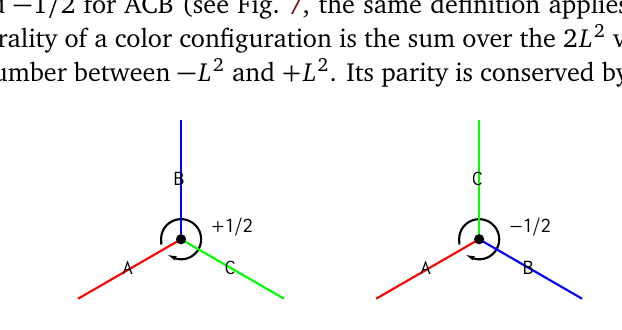
Figure 7: Definition of the chirality of a